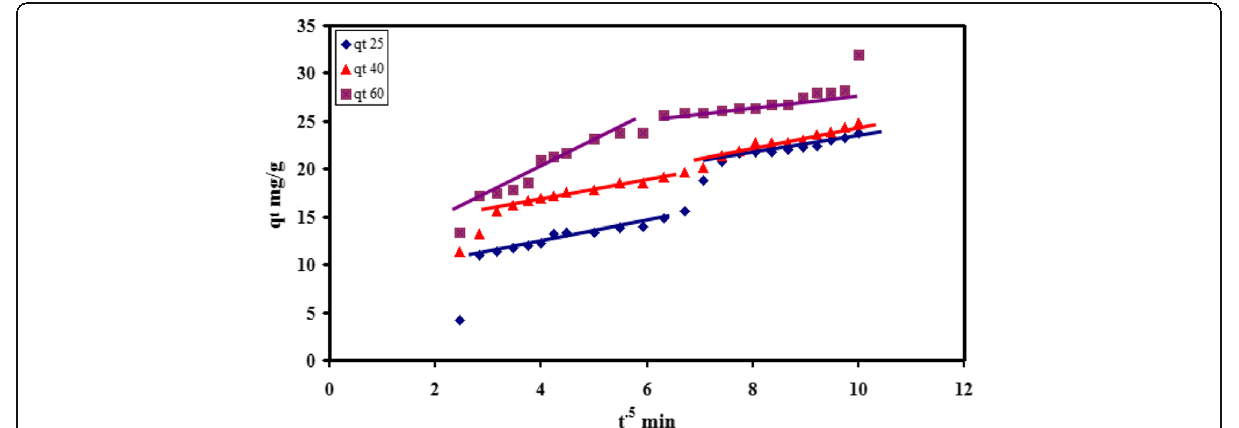
Fig. 15 Intraparticle diffusion at different